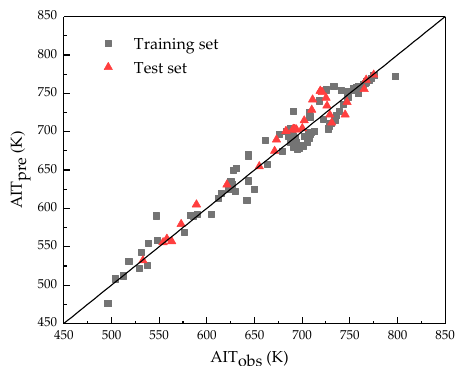
Figure 1. Correlation between the predicted and observed AIT values for both the training and test sets .